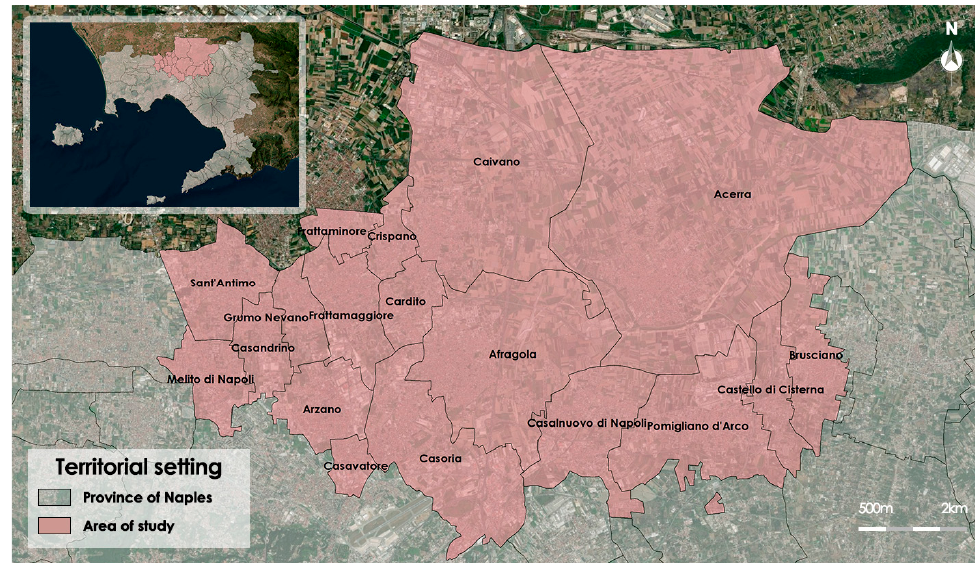
Figure 5. The study area—the 18 municipalities of the northeastern area of the province of Naples (Italy). To carry out the tests, tweets posted by users residing in the municipalities of the study area were extracted during the summer seasons of the time period analyzed. Each municipality constitutes a subzone, and the time period has been divided into three-time frames corresponding to the years 2020, 2021, and